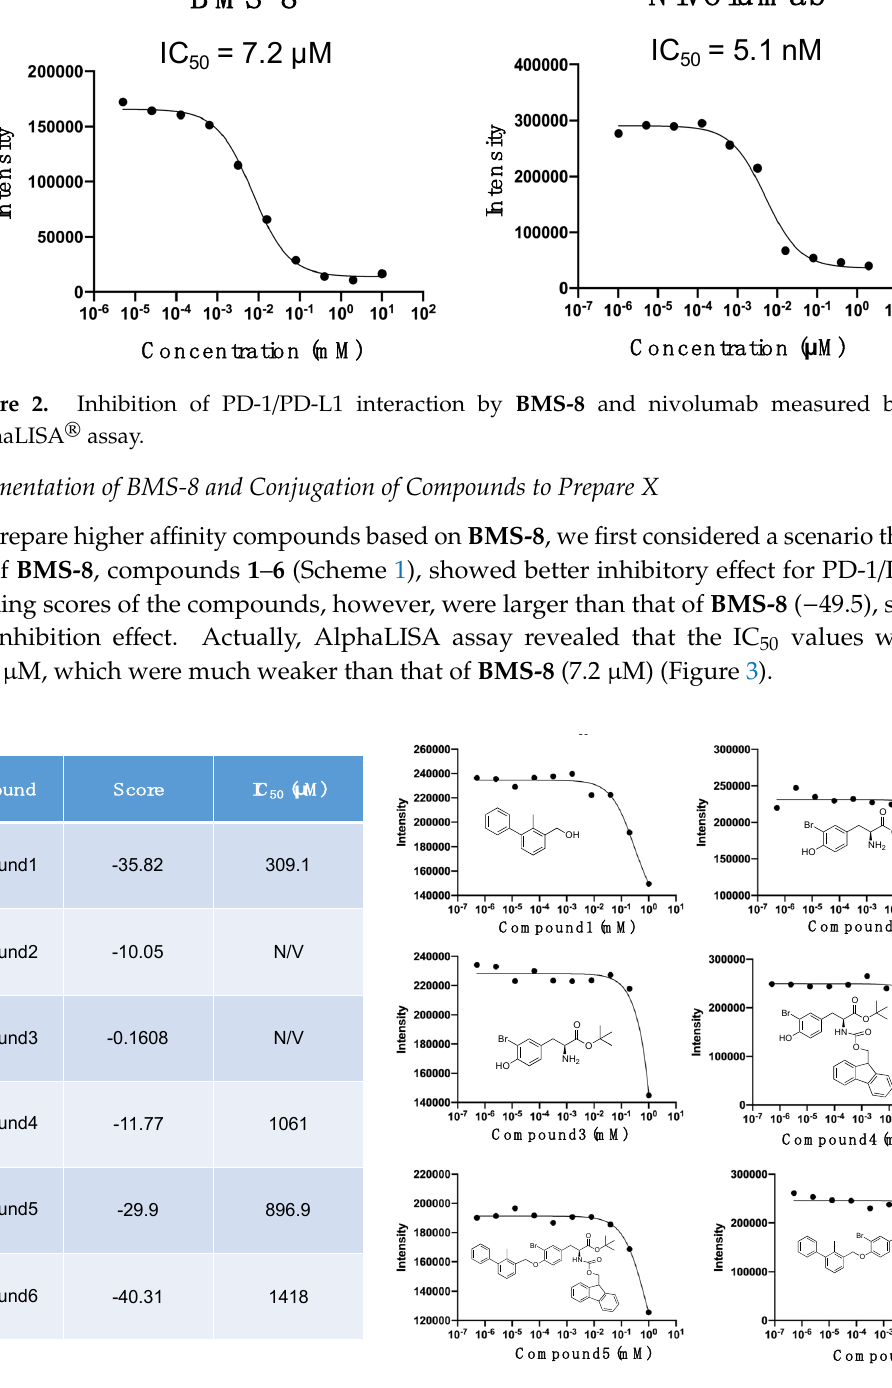
Figure 3. Docking scores, IC 50 values and measurements of compounds 1–6 . All compounds showed larger scores than that of X (score = − 42.96) with a few hundred μ M of IC 50 values.